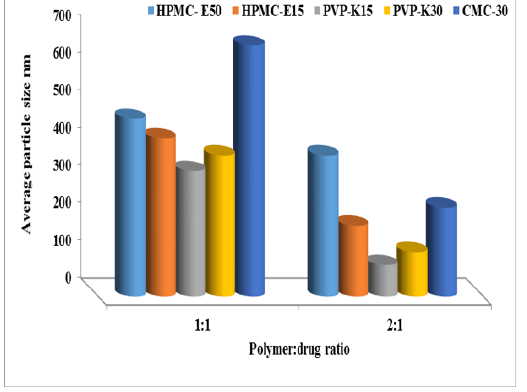
Figure 1. Effect of type and concentration of